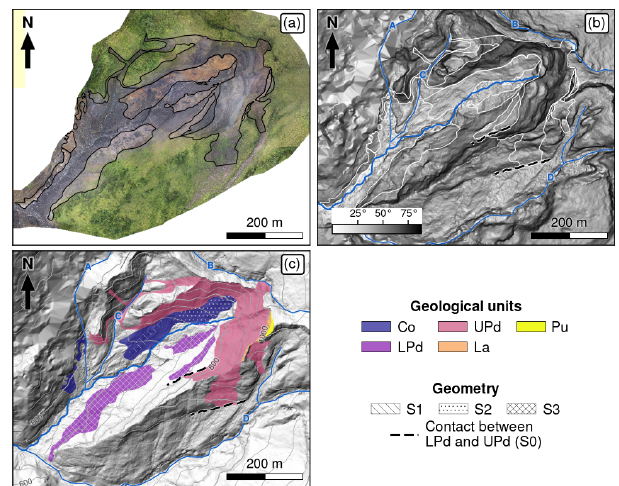
Figure 4. Geological interpretation of the Samperre cliff. (a) Au- gust 2018 orthophotograph (Hélimap/DEAL 972), with contours of identified geological units. (b) Slopes of the August 2018 DEM, completed with July 2010 DEM, with contours of identified ge- ological units. (c) August 2018 DEM, completed with July 2010 DEM. Colored patches correspond to geological units: Co, LPd, UPd, La and Pu (see main text for details). Hatched areas identify some of the surfaces used to construct a potential unstable volume (see Sect. 4.4). The contact between LPd and UPd units, inferred from slope breaks, is given in (b) and (c) by the dashed black lines. Ravines and rivers are also displayed, as in Fig. 1.